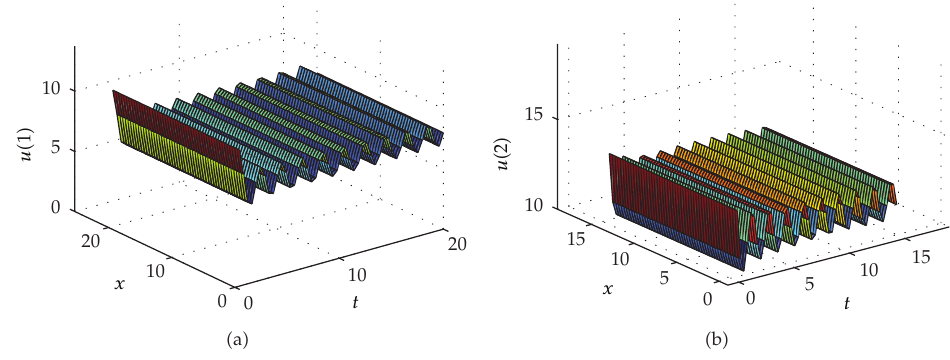
Figure 2: When b (cid:5) 0 . 1253, periodic solutions occur from Y 0 .